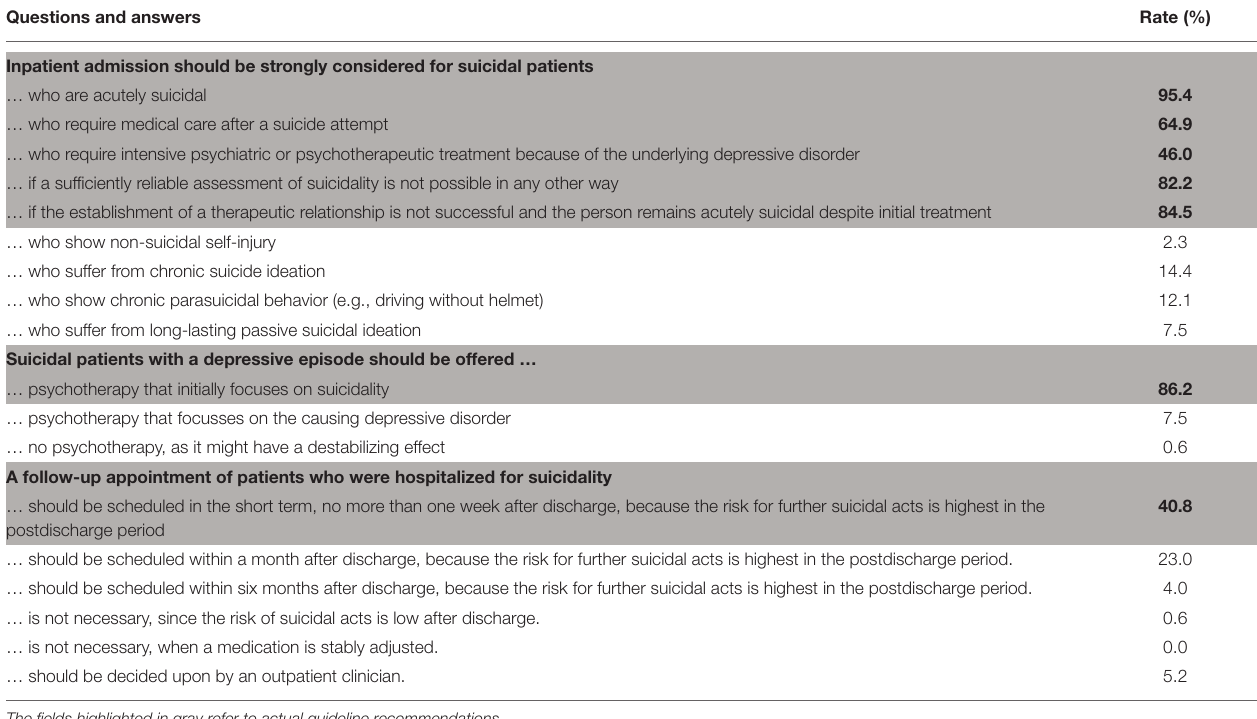
TABLE 2 | Percentages of consent to non-pharmacologic treatment recommendations.